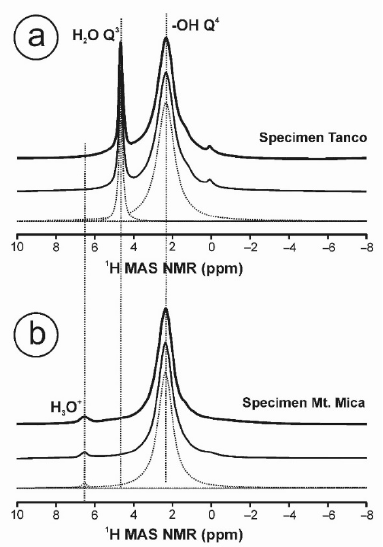
Figure 8. The 1 H MAS NMR spectra at 9.4 T of: ( a ) specimen Tanco with two major signals, one at 2.35 ppm with 1.06 ppm of linewidth from -OH groups, the other at 4.66 ppm with 0.24 ppm of linewidth from H 2 O from phyllosilicate impurities and/or fluid inclusions; and ( b ) specimen Mt. Mica with one major resonance at 2.35 ppm with 0.9 ppm of linewidth from -OH groups, and a minor signal at 6.52 ppm, perhaps from H 3 O + .